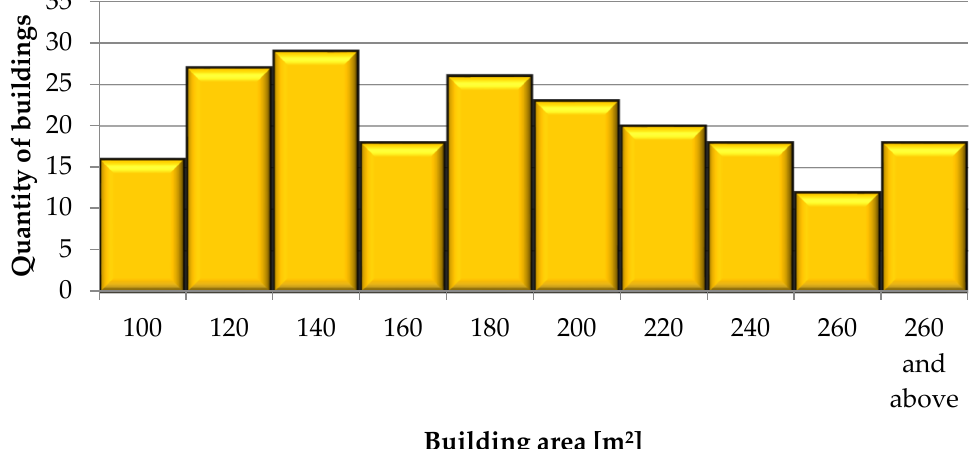
Figure 8. Distribution of data for the variable relating to the width of the buildings [m].